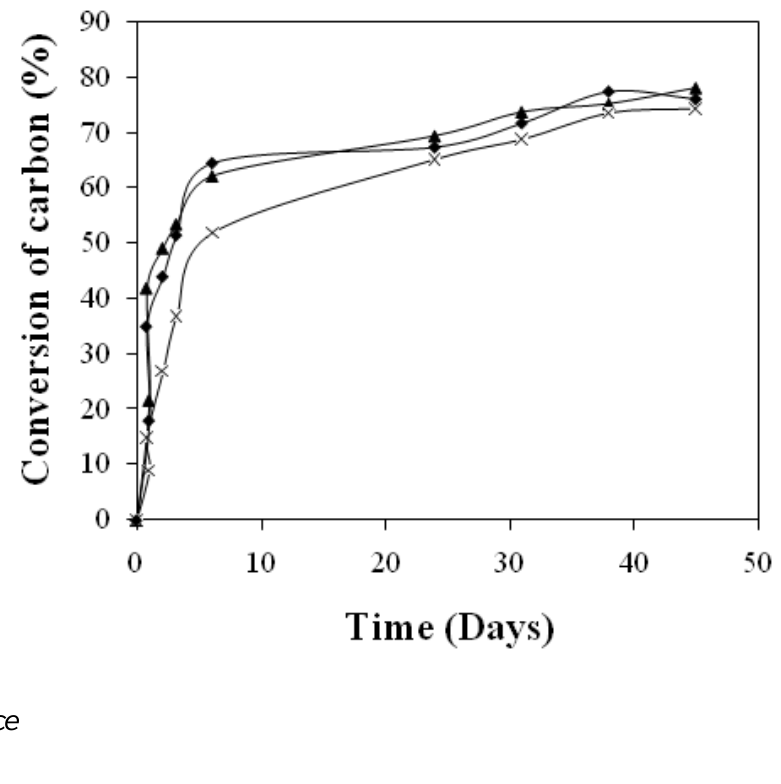
Figure 3. Mineralization curve for co-extruded film degradation during the tests in the activated inert solid medium ( (cid:141) ), no activated inert solid medium (x) and medium compost ( (cid:99)